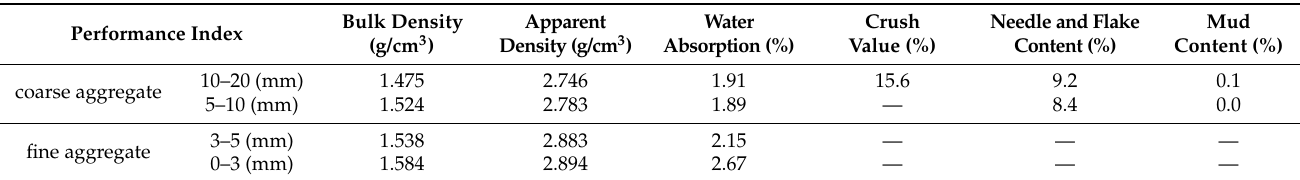
Table 1. Test results of physical properties of aggregates.